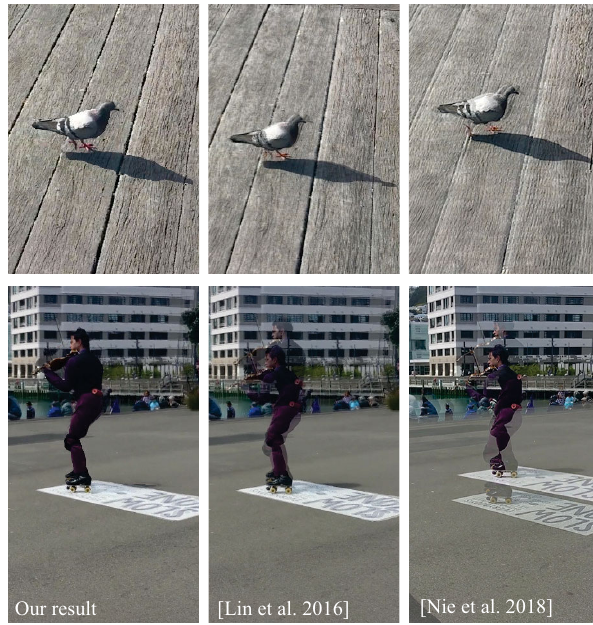
Fig. 9 Comparison with state-of-the-art video stitching